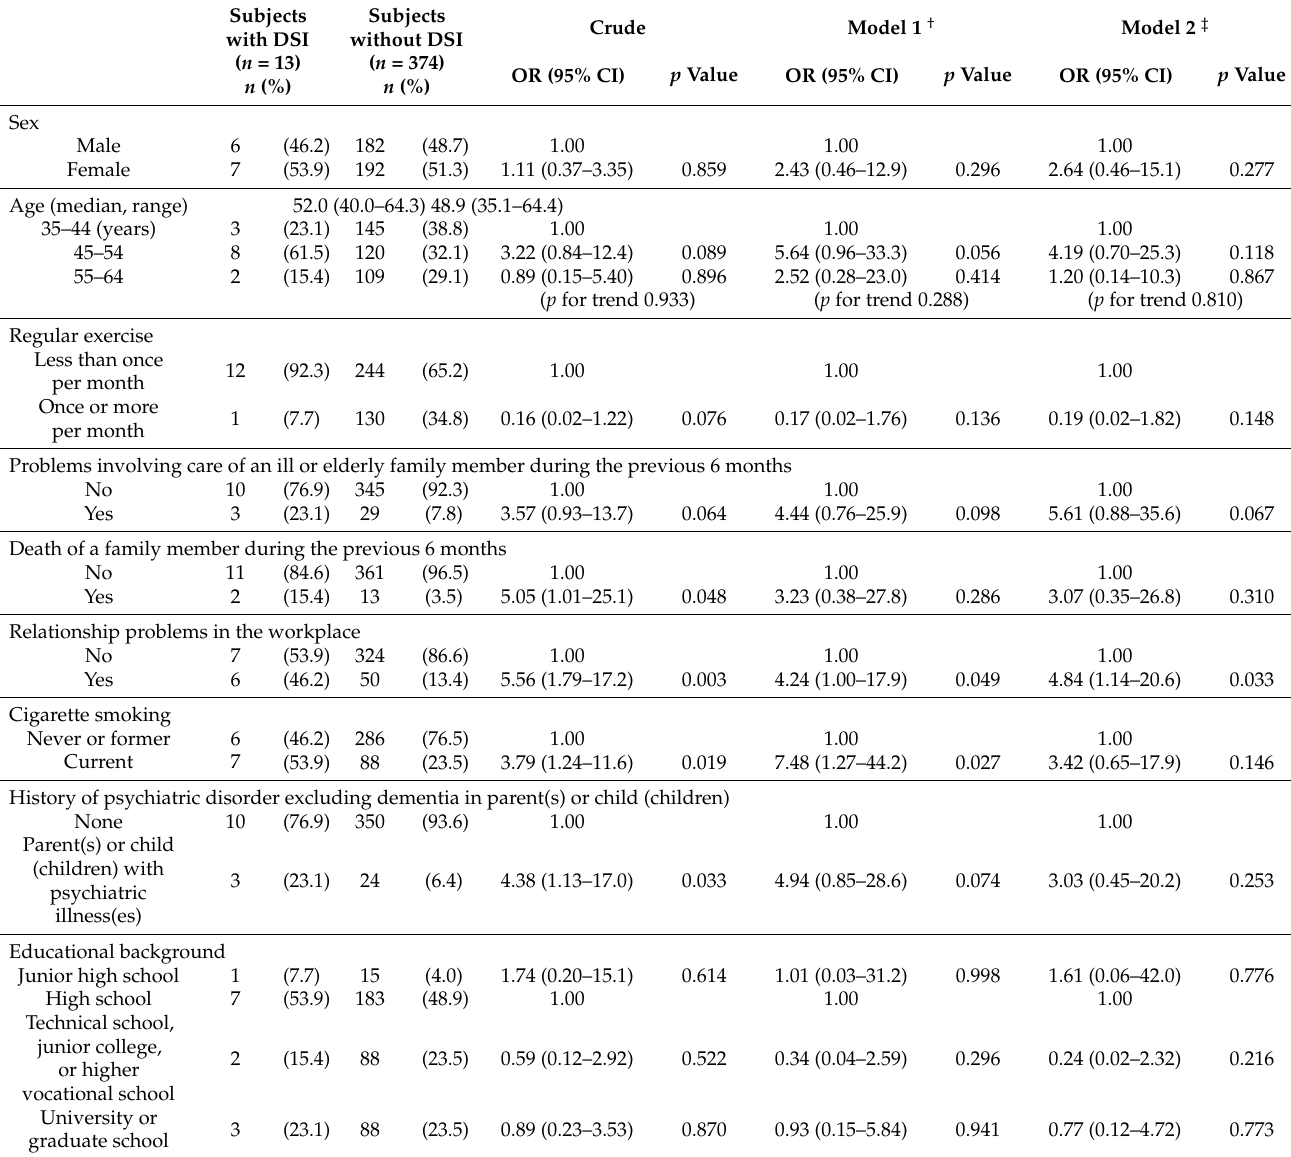
Table 1. Odds ratios for depression with suicidal ideation (DSI) and characteristics of subjects with and without DSI among primary care patients aged 35–64